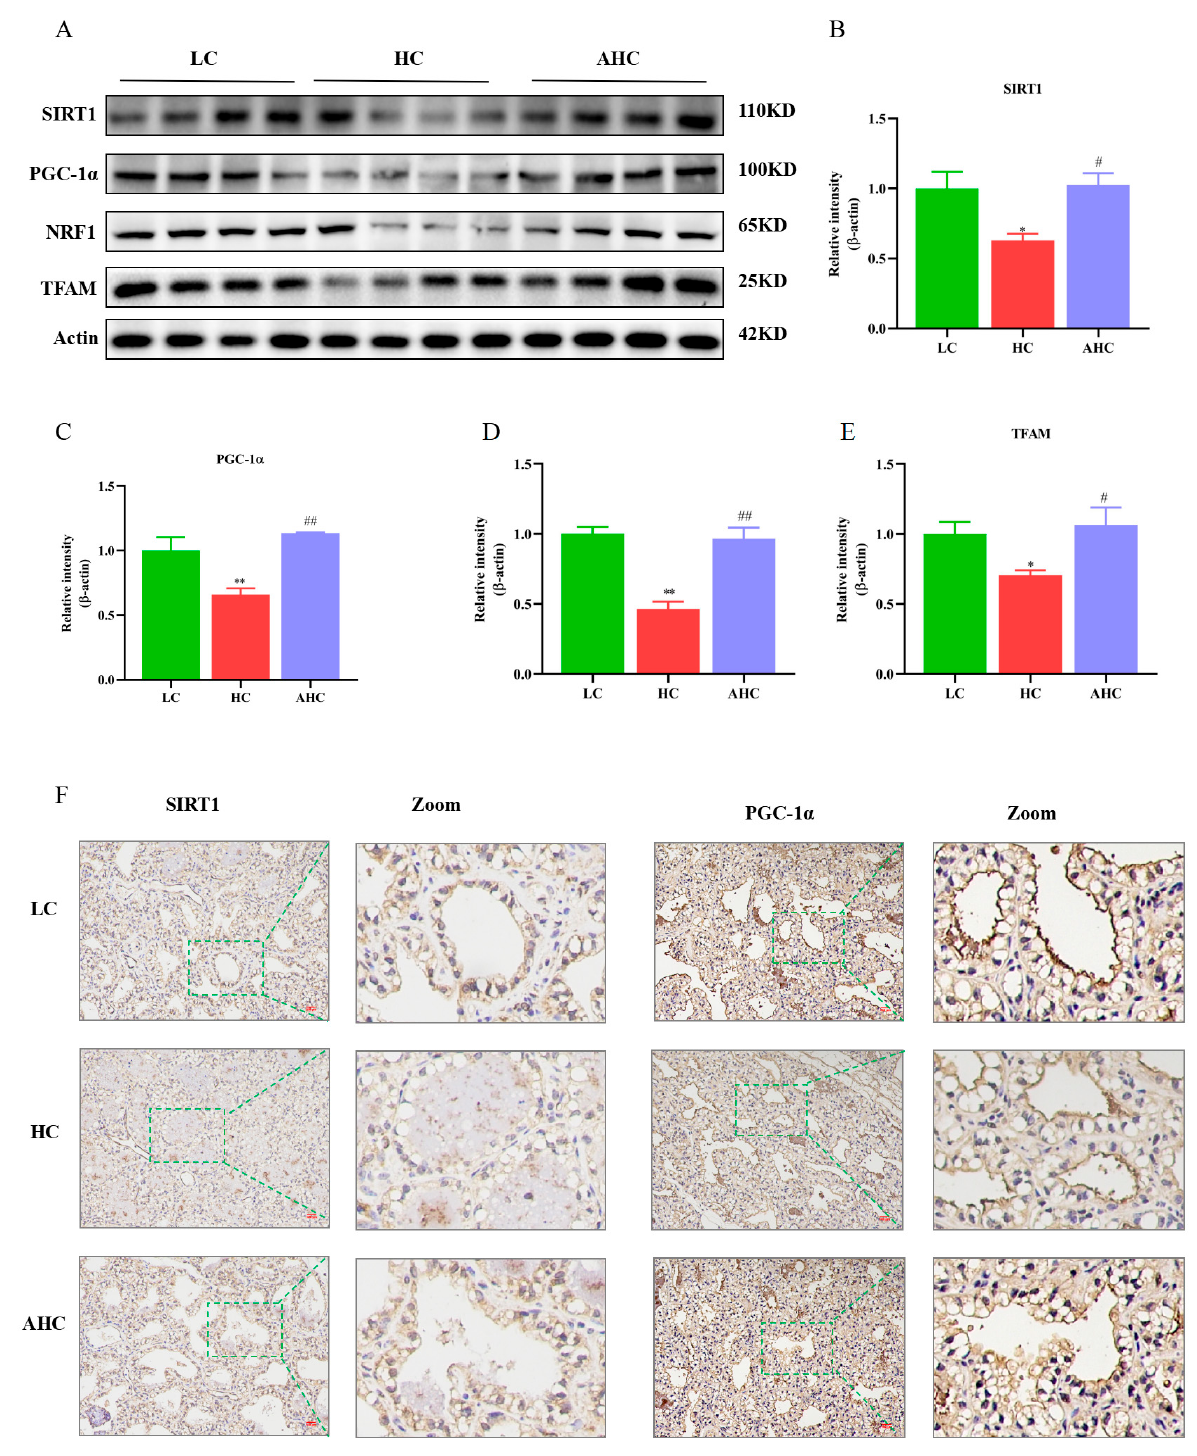
Figure 4. The effects of the high-concentrate diet supplemented with disodium fumarate on mito- chondrial biogenesis in the mammary gland tissue of Hu sheep. Mitochondrial biogenesis-related protein expression ( A – E ). Data are presented as the relative protein abundances relative to actin (means ± SEM). * p < 0.05, ** p < 0.01 represent significant differences compared with the LC diet. # p < 0.05, ## p < 0.01 represent significant differences compared with the HC diet. Immunohistochemical results of SIRT1 and PGC-1 α in the mammary gland tissue of Hu sheep. The bar = 100 μ m ( F ). The green line represents zooming in on the selected area of the image.